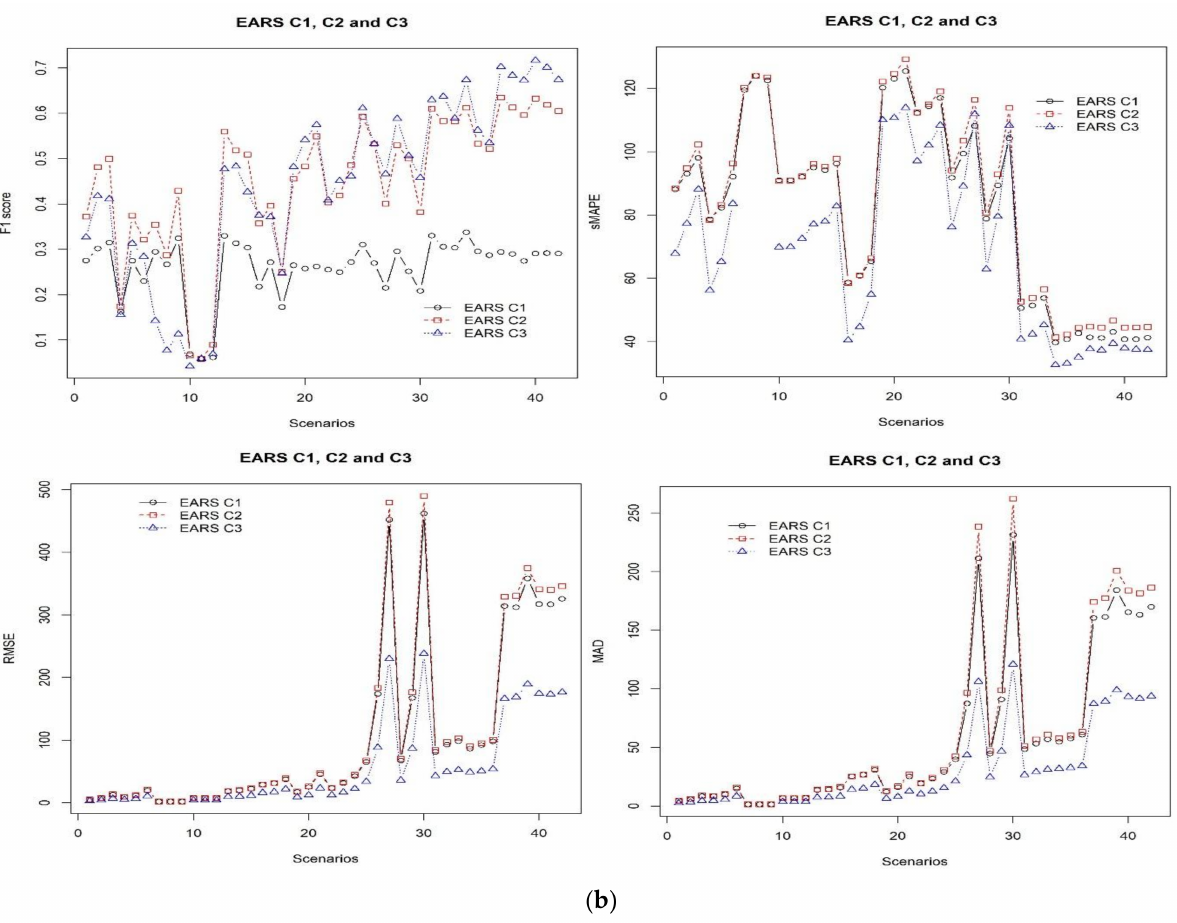
Figure 4. ( a ) The results of comparing EARS C1, C2, and C3 in terms of sensitivity, specificity, PPV, and NPV across the all scenarios. EARS C3 showed better performance in almost all cases. ( b ) The results of comparing EARS C1, C2, and C3 in terms of F1 score, sMAPE, RMSE, and MAD across the all scenarios. EARS C3 showed better performance in almost all cases as it showed lower values of sMAPE, RMSE, and MAD, and higher values of F1